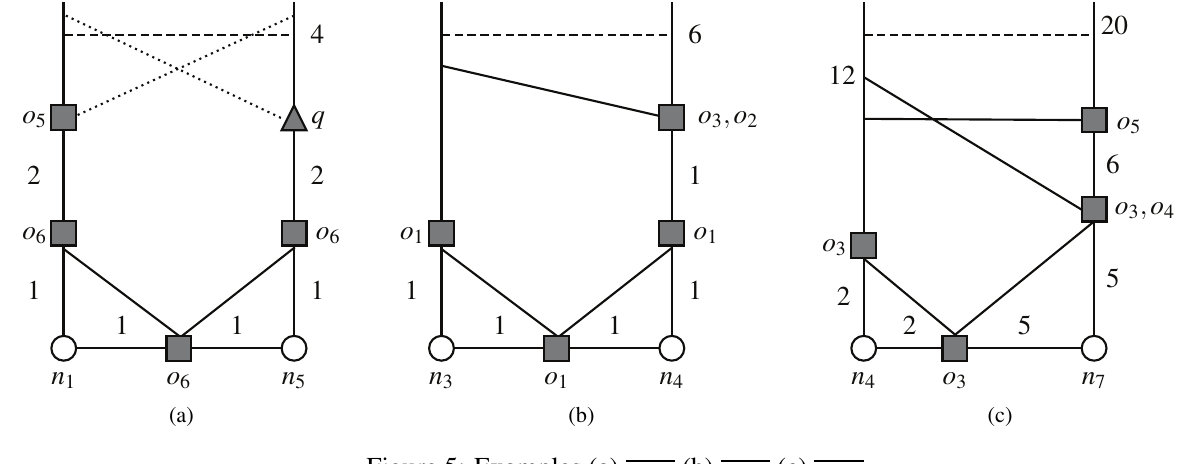
Figure 5: Examples (a) n 1 n 5 (b) n 3 n 4 (c) n 4 n 7